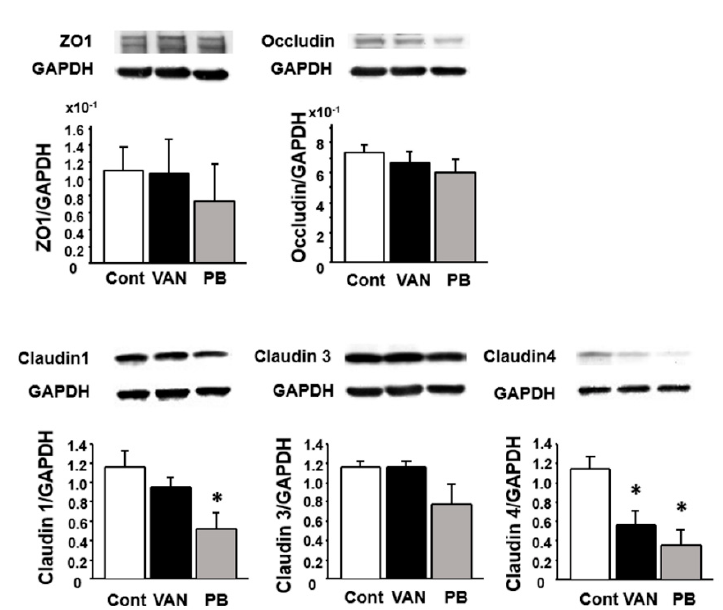
Figure 6. Effect of antibiotic treatment on the expression of tight junction proteins in mice colonic tissues. Results are expressed as mean ± SE ( n = 5 in each group). Cont, control; VAN, vancomycin; PB, polymyxin B. Significantly lower than in the control: * p < 0.05.